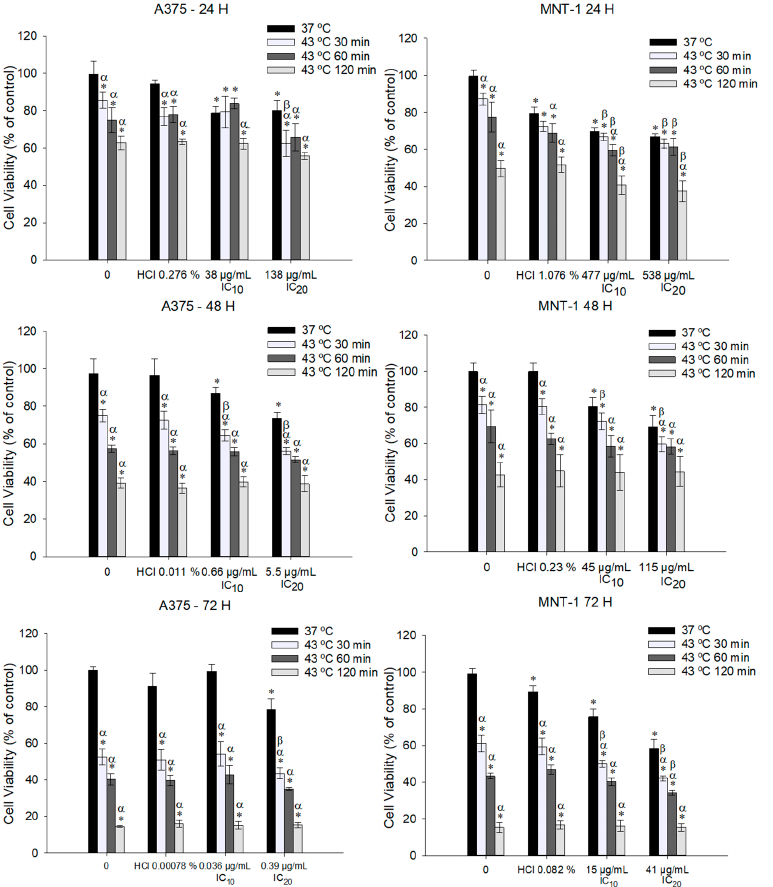
Figure 3. Effect of 43 ◦ C hyperthermia plus DTIC on viability of A375 and MNT-1 cells. Cells were submitted to hyperthermia for 30, 60 or 120 min plus 38 µ g/mL or 138 µ g/mL and 477 µ g/mL or 538 µ g/mL during 24 h, 0.66 µ g/mL or 5.5 µ g/mL and 45 µ g/mL or 115 µ g/mL during 48 h, and 0.036 µ g/mL or 0.39 µ g/mL and 15 µ g/mL or 41 µ g/mL during 72 h, in case of A375 or MNT-1, respectively. Concentrations correspond to the calculated DTIC IC10 and IC20 for each time exposure and for each cell line. HCl concentrations correspond to the equivalent percentage present in DTIC IC20 of each cell line and time exposure. Cell viability was determined using MTT assay. Data shown are the mean values ± standard deviation of two independent experiments, with four technical replicates each. * indicates statistical significance in comparison to the control 37 ◦ C, α indicates statistical significance in comparison to the respective condition at 37 ◦ C and β indicates statistical significance of the conditions with hyperthermia in comparison to hyperthermia alone ( p <